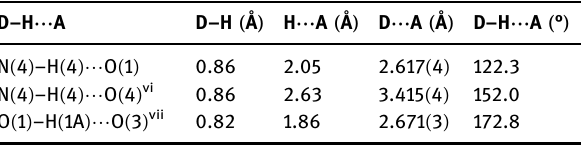
Table 1: H - bonding geometry parameters ( Å, ° ) for complex 1